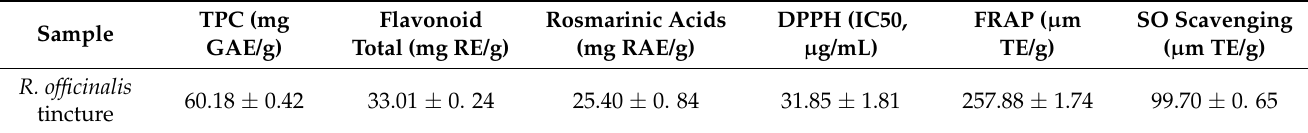
Table 3. Polyphenols content and antioxidant activity of the fresh young shoots R. officinalis tincture. TPC (mg Flavonoid Rosmarinic Acids DPPH (IC50, FRAP ( µ m SO Scavenging Sample µ g/mL) GAE/g) Total (mg RE/g) (mg RAE/g) TE/g) ( µ m TE/g) R. officinalis 60.18 ± 0.42 33.01 ± 0. 24 25.40 ± 0. 84 31.85 ± 1.81 257.88 ± 1.74 99.70 ± 0. tincture